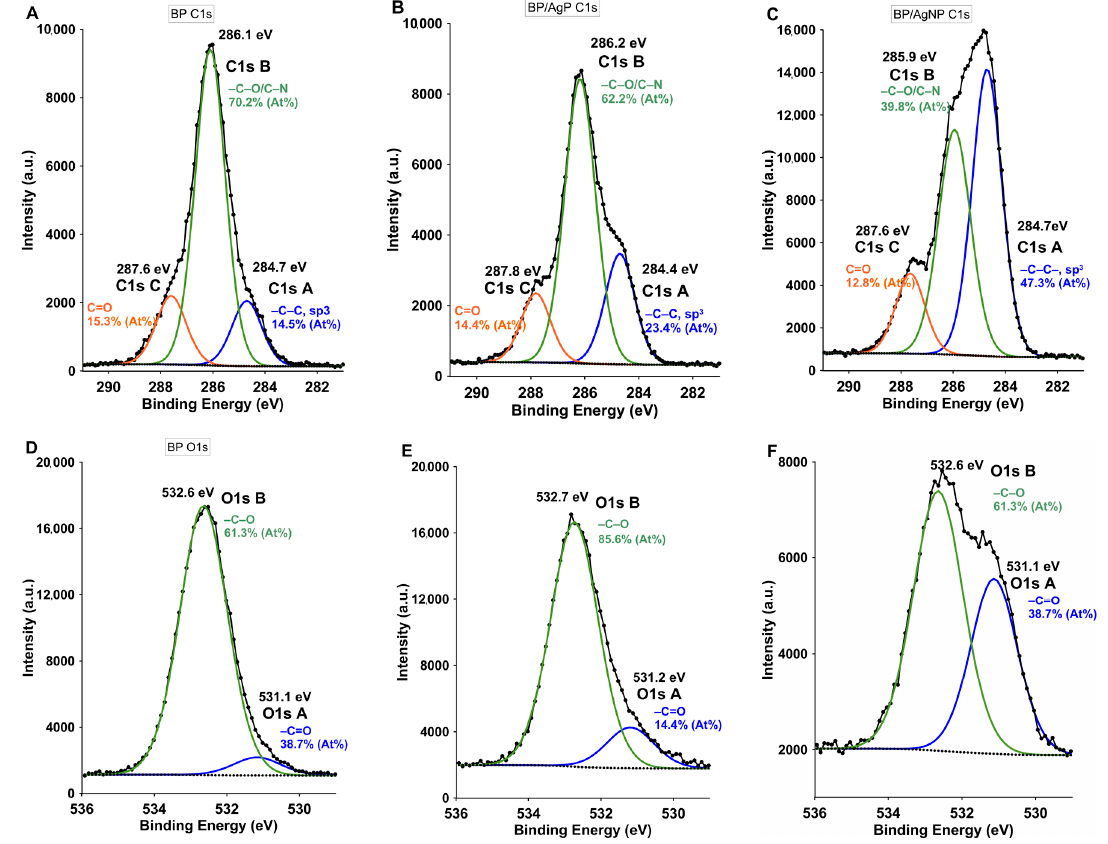
Figure 4. XPS high resolution spectra of C1s photoelectron lines for ( A ) BP, ( B ) BP / AgP, ( C ) BP / AgNP and O1s for ( D ) BP, ( E ) BP / AgP and ( F ) BP / AgNP samples.